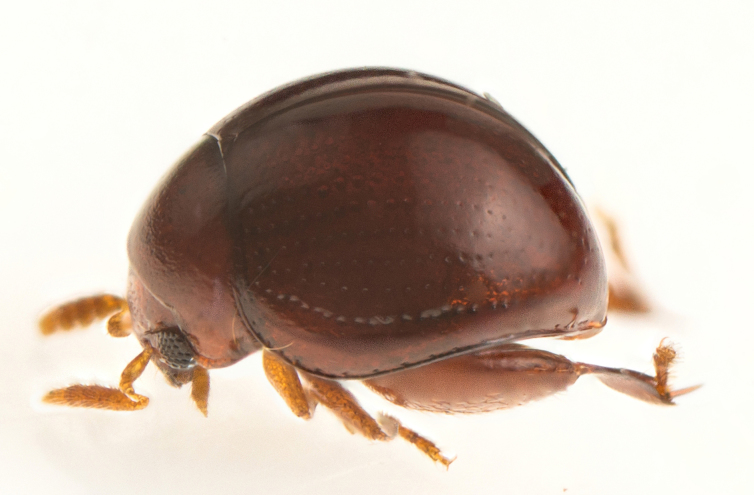
dorsolateral view